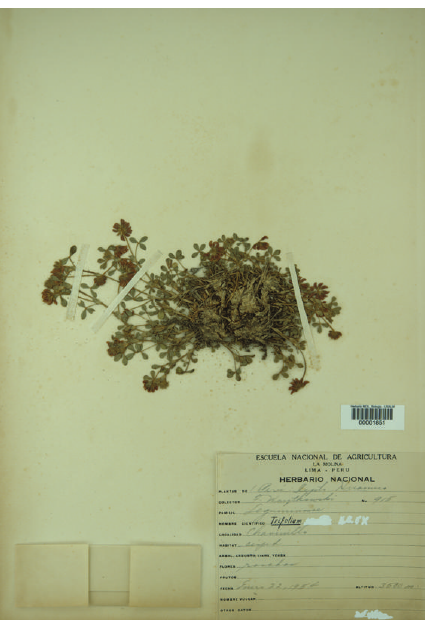
Figure 3: Woytkowski 915 : holotype of Trifolium absconditum Molinari, sp. nov.